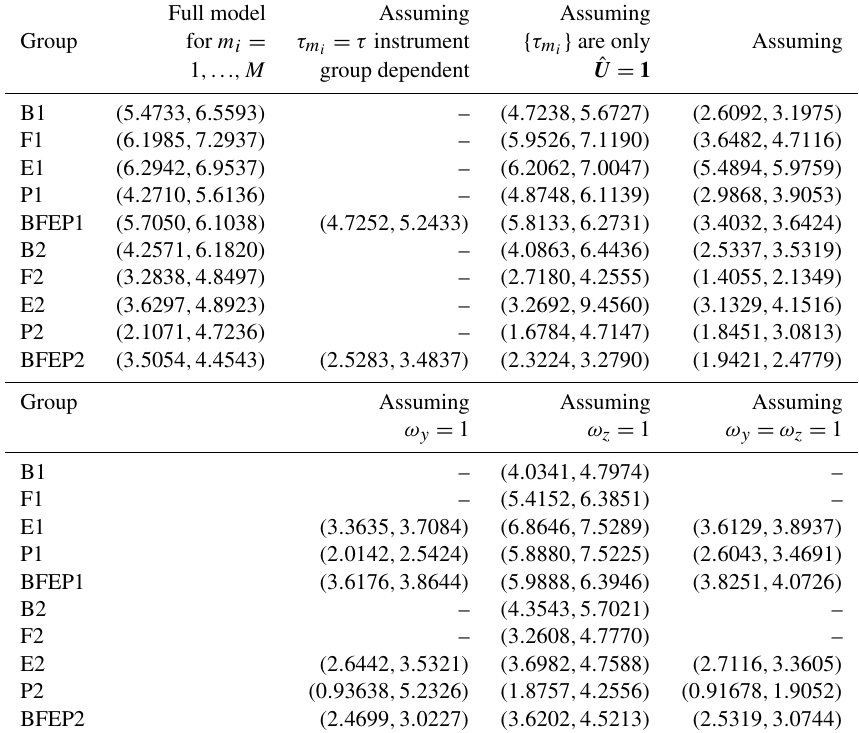
Table A2. Posterior 95% credible intervals for the emission rates in grams per minute (gmin − 1 ) for the Boreal lasers (B), FTIR spectrometers (F), EC towers (E), Picarro analysers (P), and an ensemble of all instruments (BFEP), for each release-rate period (5.8gmin − 1 (1), and 5.0gmin − 1 (2)) and for various alterations to the model as detailed in Sect. 6. Dashes correspond to the redundant case (e.g. ω y = 1 was assumed for all path measurements in the full